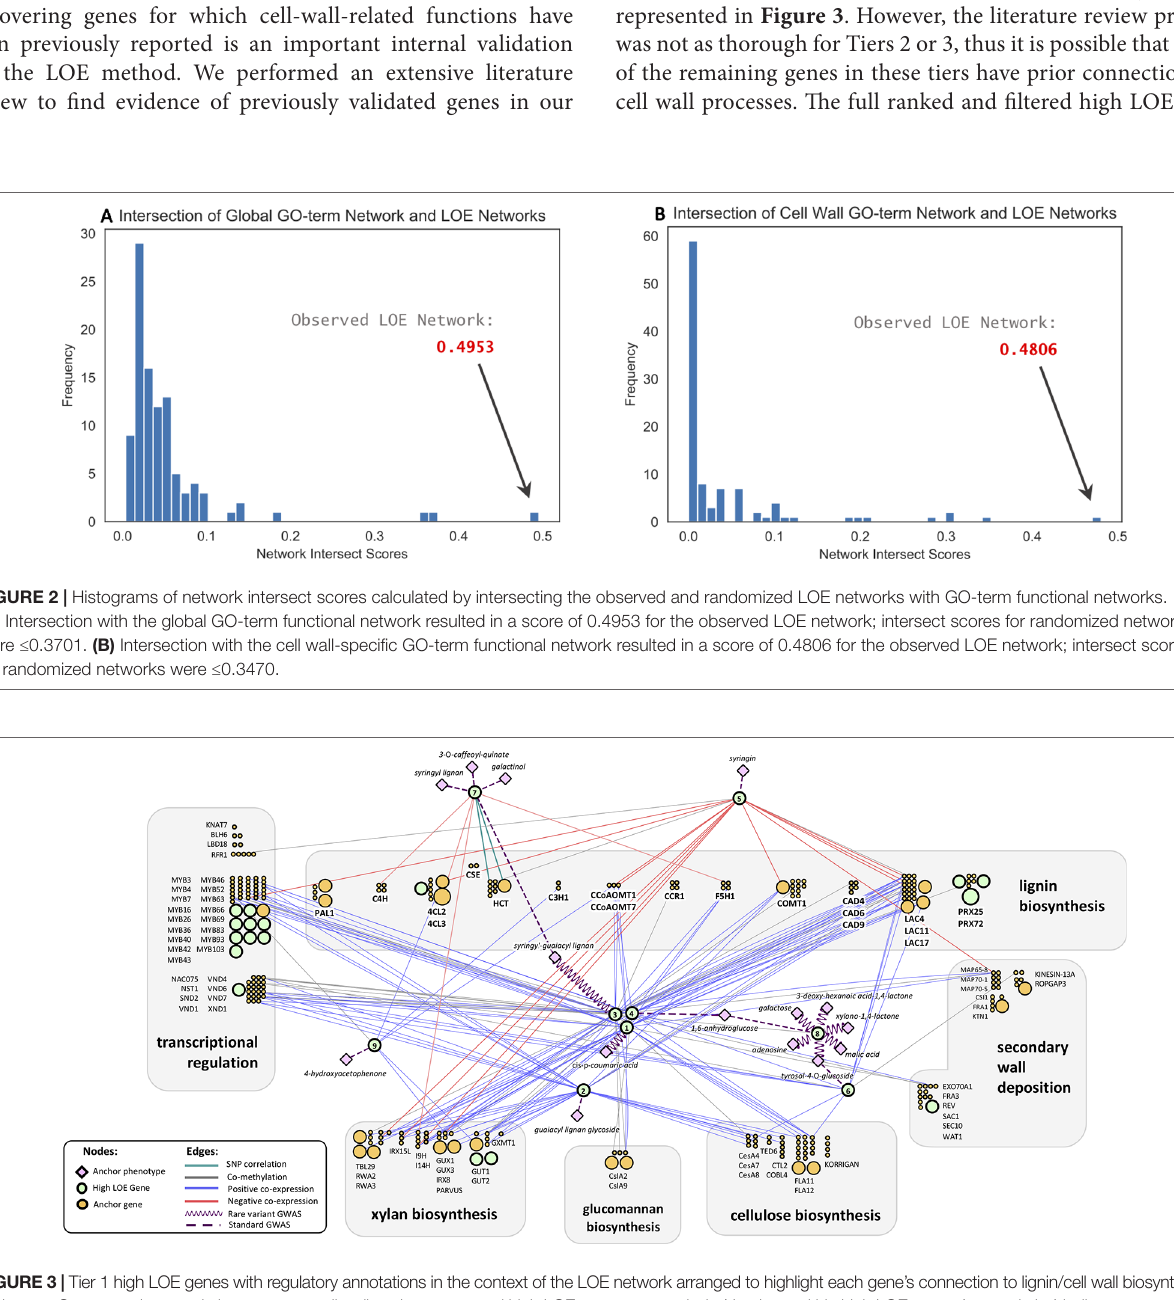
FIGURE 3 | Tier 1 high LOE genes with regulatory annotations in the context of the LOE network arranged to highlight each gene’s connection to lignin/cell wall biosynthesis pathways. Orange and green circles represent cell wall anchor genes and high LOE genes, respectively. Numbers within high LOE genes (green circles) indicate an entry within Table 1 . Green circles that do not contain numbers represent a subset of the high LOE genes that were filtered from the final results set due to having prior evidence of cell-wall-related functions in the literature. The size of circles corresponds to their LOE breadth score. Gene symbols are Arabidopsis Best-hit